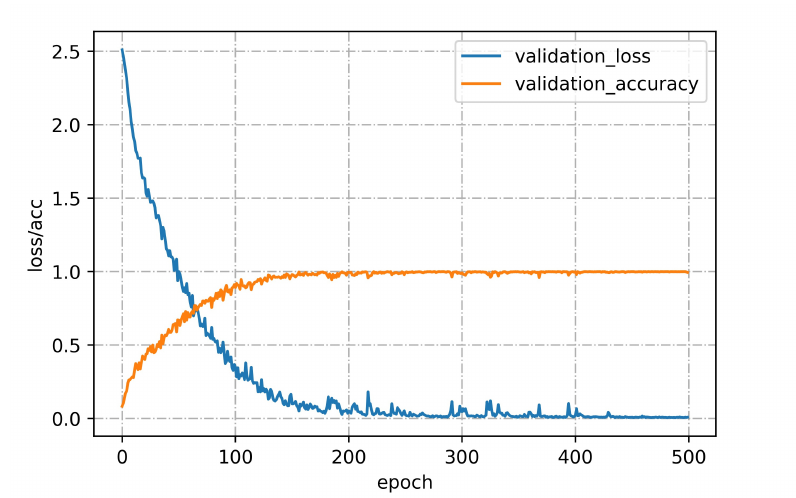
Figure 11. Loss and cross-validation curves of the CNN model during the training